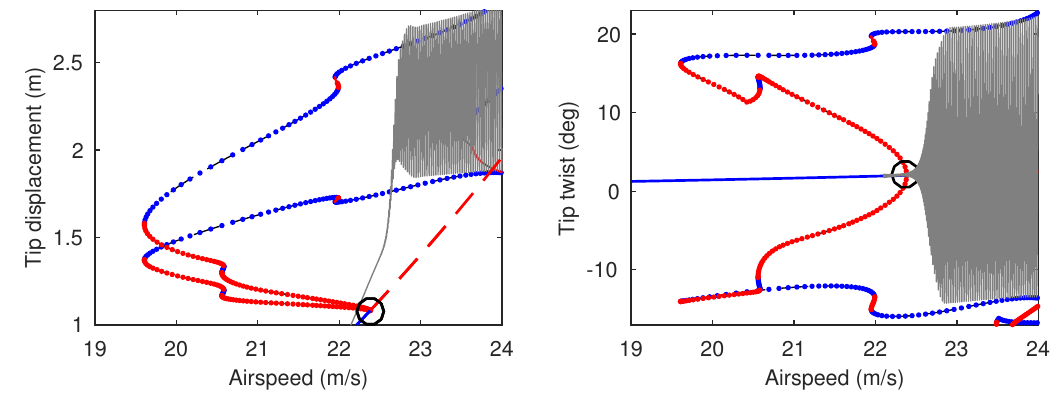
Figure 7. Time histories from Figure 5 superimposed onto continuation solutions from Figure 6.